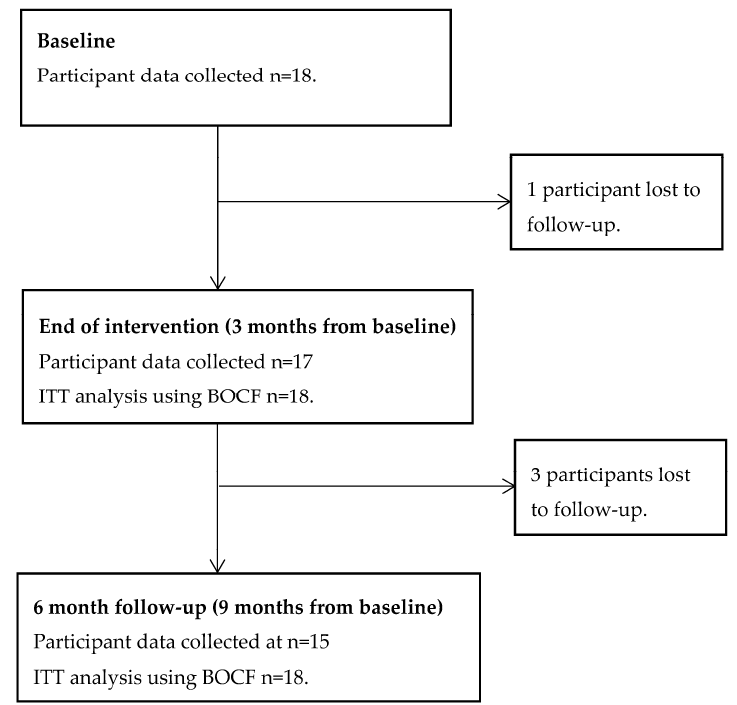
Figure 1. This figure shows the flow of participants through the feasibility trial.